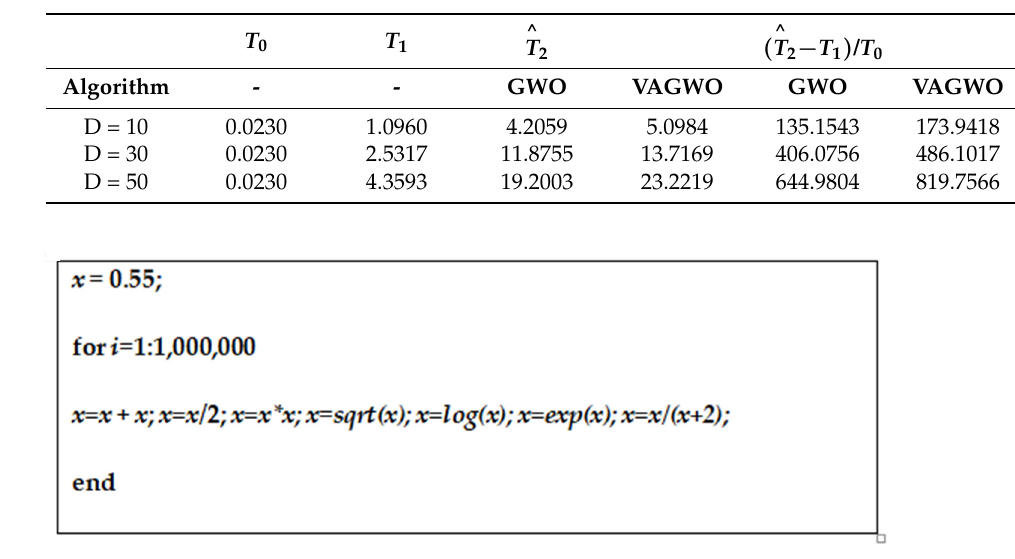
Figure 7. The process of computing time T 0 . Table 13. The computational complexity of VAGWO against GWO.